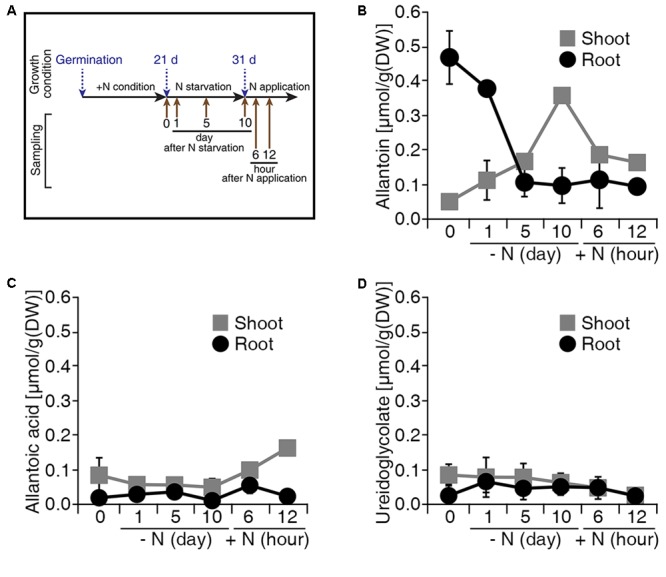
Levels of allantoin metabolites are sensitive to N status in rice. (A) Design of the N starvation and re-application experiment. Dongjin wild type plants were grown for 21 days on soil and hydroponic Yoshida solution with different N sources. Seedlings were transferred to N starvation conditions for 10 more days, which consisted of the Yoshida solution without N sources. After N starvation, NH4NO3 was added to the solution (2.8 mM final concentration), defined as the N re-application condition. Levels of allantoin (B), allantoic acid (C), and ureidoglycolate (D) in shoots and roots in response to N starvation and re-application. Values represent the mean + SE of two biological and two technical replicates.